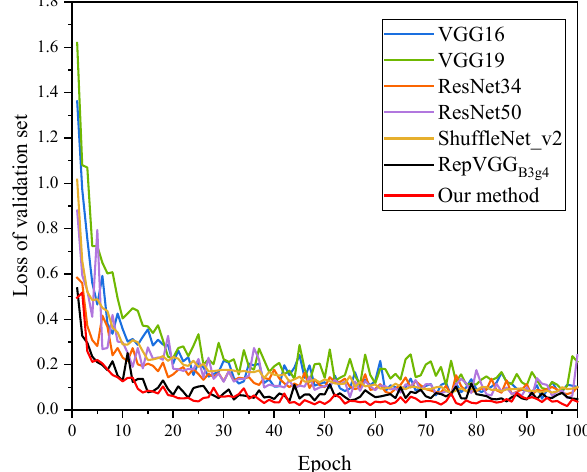
Figure 10. Comparison of the accuracy of each method training set.